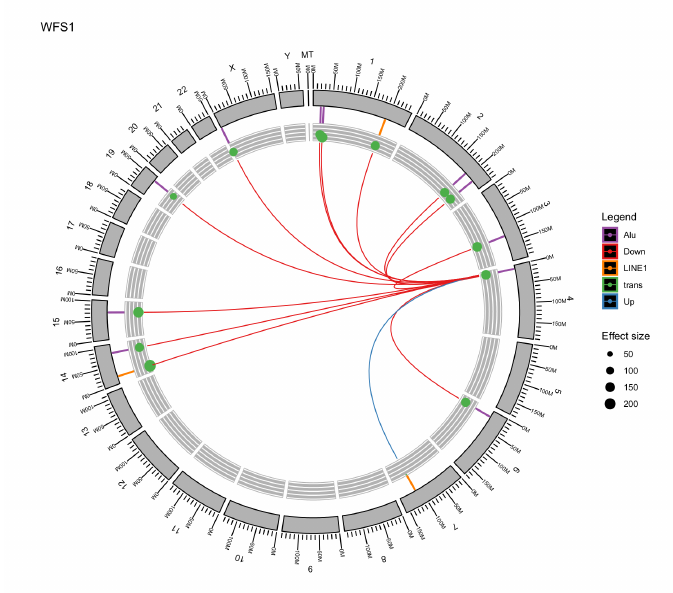
Figure 10. Circos plot of the TEs regulating the WFS1 gene. Alu and L1 are indicated as purple or yellow bars respectively. Green dots indicate trans-regulating effects. Dot size illustrates beta value. Colour of the line indicates up-regulation (blue) or down-regulation